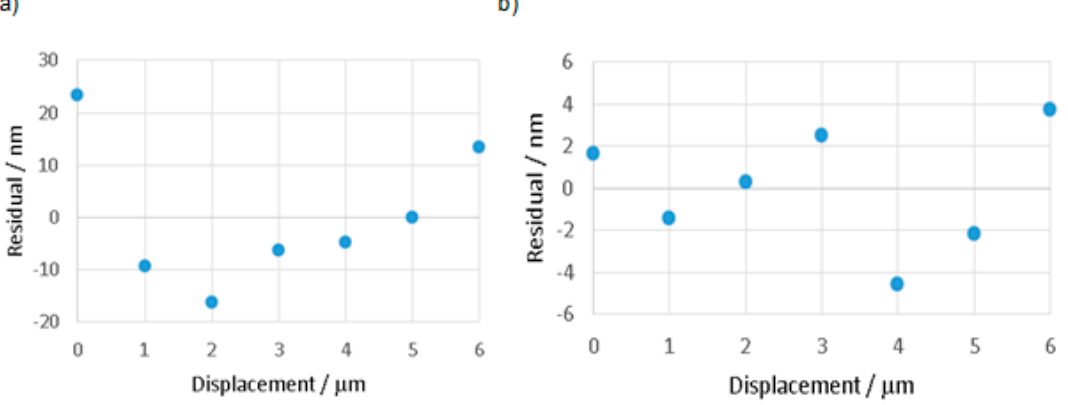
Figure 15. Plot shows the residual against fitted value, where the maximum nonlinearity is ( a ) 23 nm in z direction and ( b ) 4 nm in y direction for full range (6 µm).